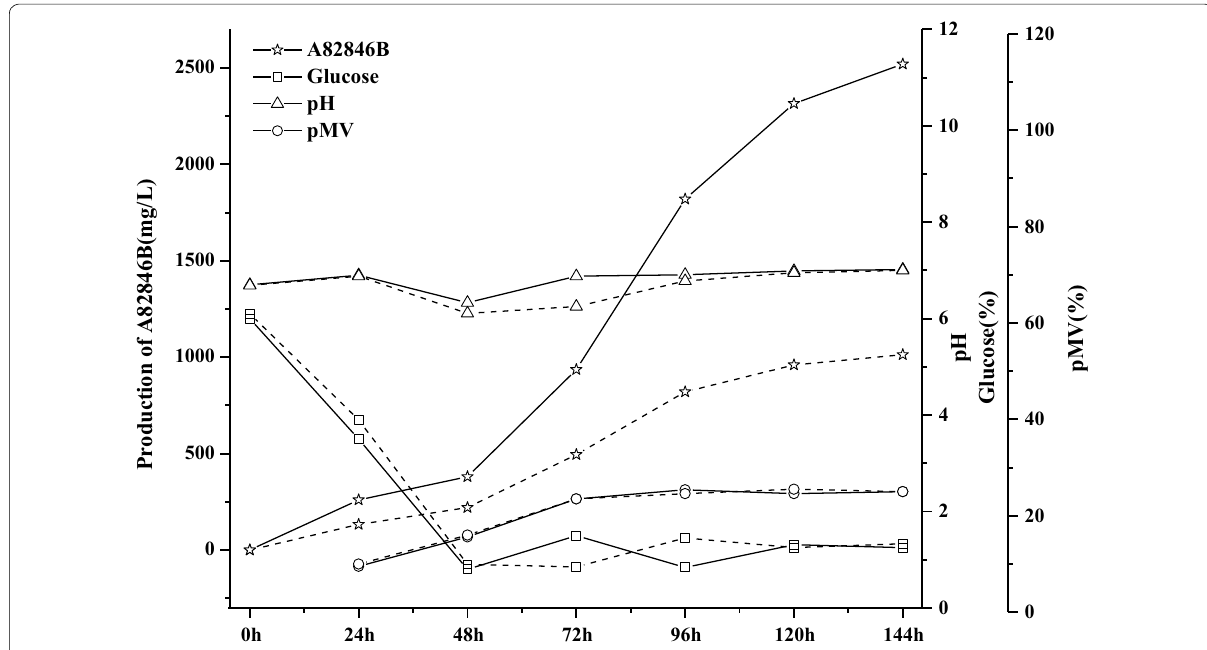
Fig. 5 Comparison metabolic curves between recombinant strain SIPI‑3927‑C6 and parent strain SIPI‑3927 in 5L fermentor. Solid line, SIPI‑3927‑C6; dotted line, SIPI‑3927